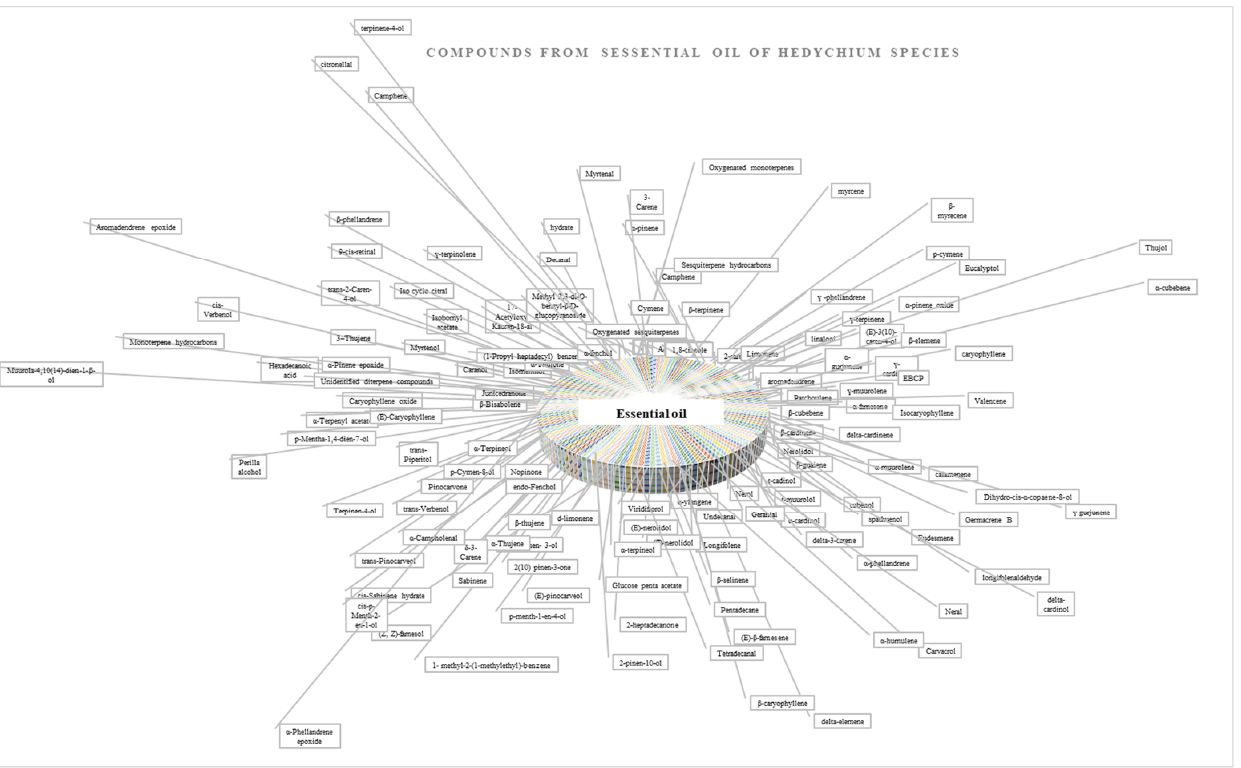
Figure 4. Chemical composition of essential oil obtained from Hedychium species.